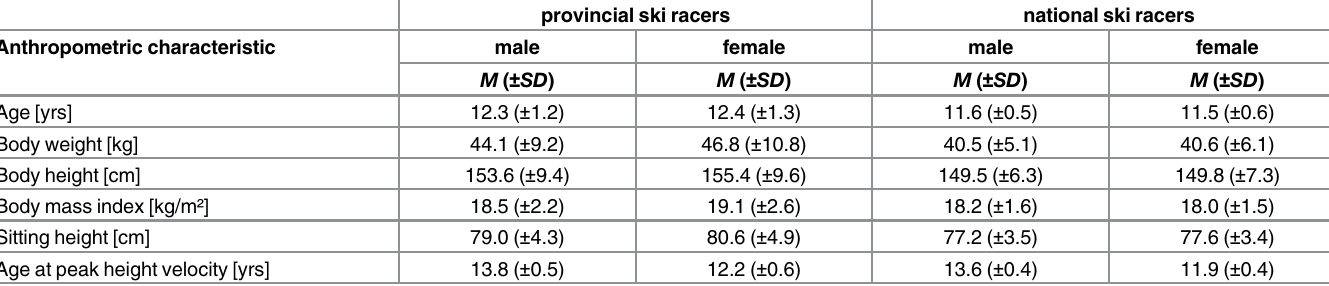
Table 1. Anthropometric characteristics separated by gender and group of ski